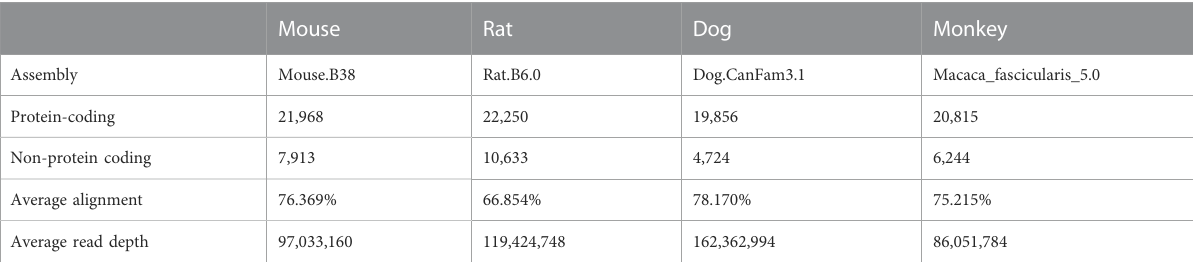
TABLE 2 Transcript mapping information across